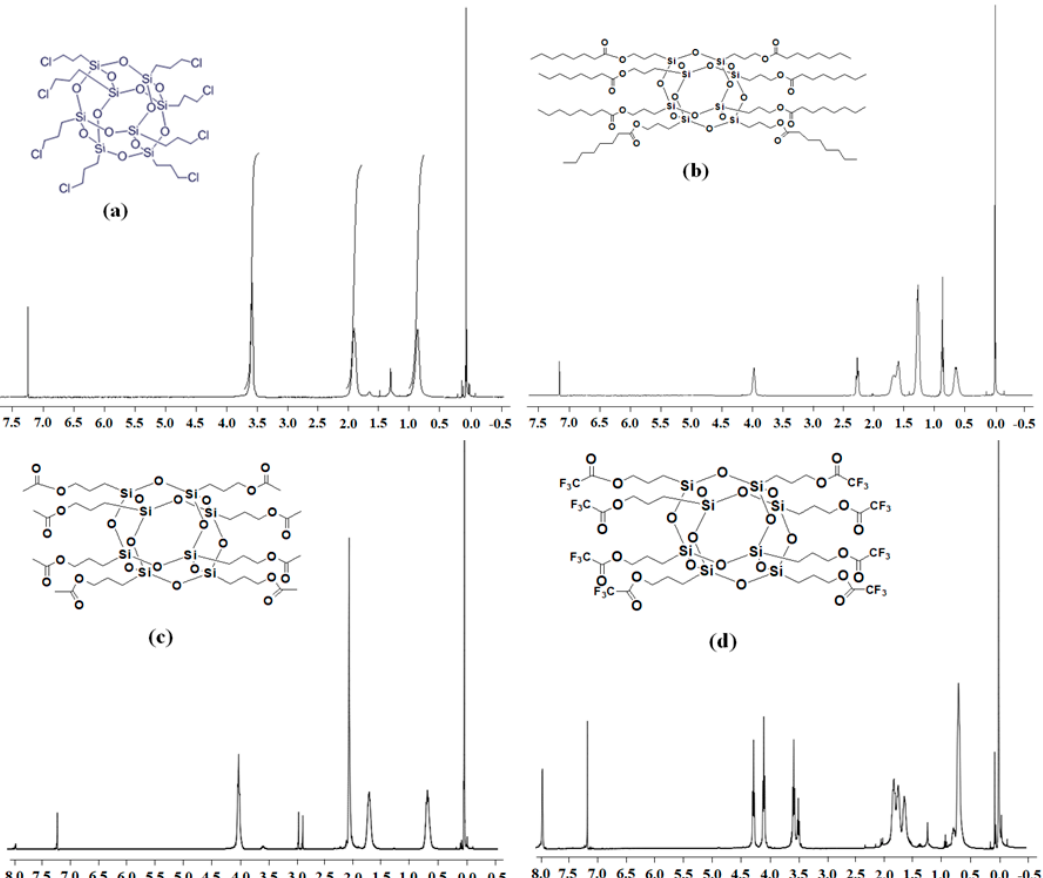
Figure 3. 1 H-NMR spectrum of POSS-compounds in CDCl 3 . (a) Octa-chloro-POSS: δ 0.78 (t,